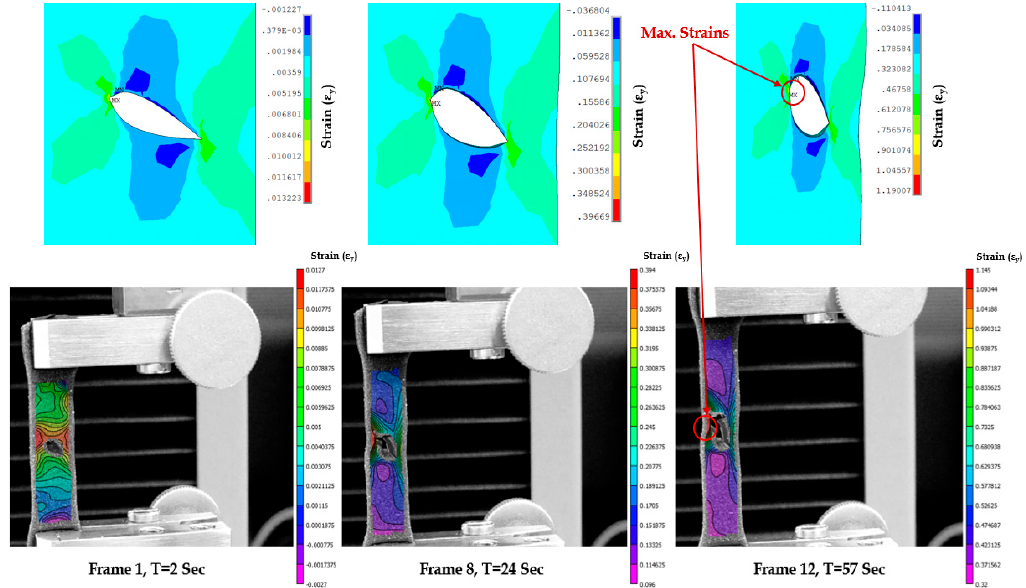
Figure 20. Local strains around the wound compared at different times in the computational model and DIC measurements.